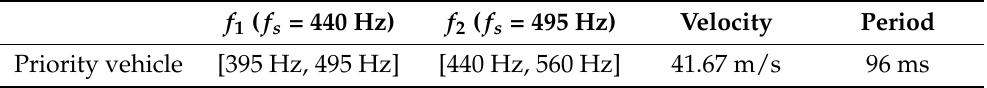
Table 4. Profile of sound source.